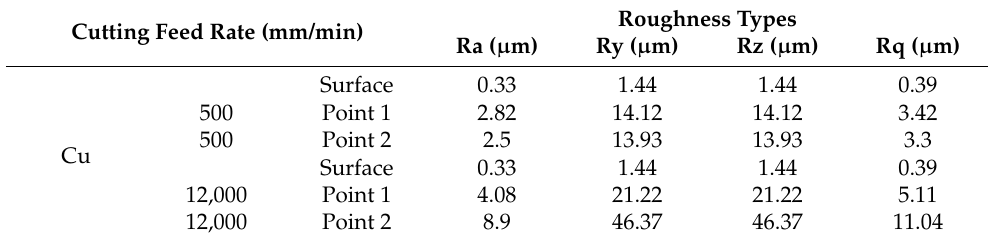
Table 7. Results of the roughness